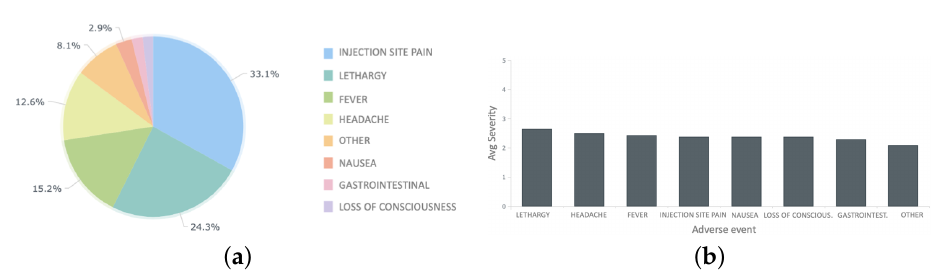
Figure 9. Distribution of reported adverse events on our platform by type ( a ) and by severity ( b ).